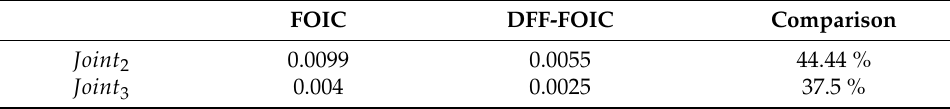
Figure 20. Joint-tracking curve comparison of FOIC and DFF-FOIC. ( a ) joint 2 . ( b ) joint 3 . Table 11. ITAE joint-tracking comparison of FOIC and DFF-FOIC.